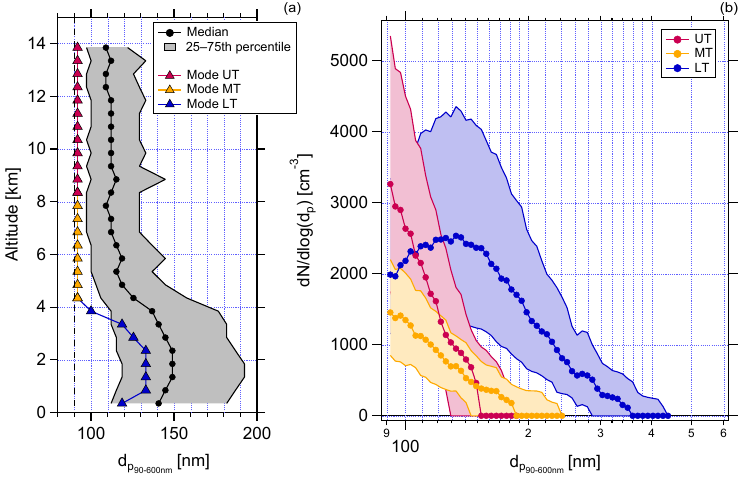
Figure 6. Vertical profile of the medians (black dots) and the mode (triangles) of the binned size distributions (a) , and median and interquartile size distributions of particles between 90 and 600nm in the UT (pink), in the MT (yellow), and in the LT (blue) (b) . The grey area in (a) gives the interquartile range. The dotted line in (a) indicates the lower cutoff of the considered size range of the UHSAS-A. The statistics shown in both (a) and (b) are calculated from all valid UHSAS-A data from 10 flights (AC07-AC10, AC15-AC20). Data are calculated for STP conditions.